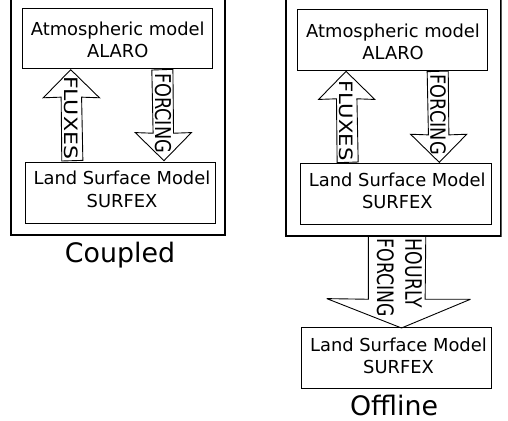
Figure 1. Schematic overview of the coupled and offline set-ups, used for the perturbed runs of the